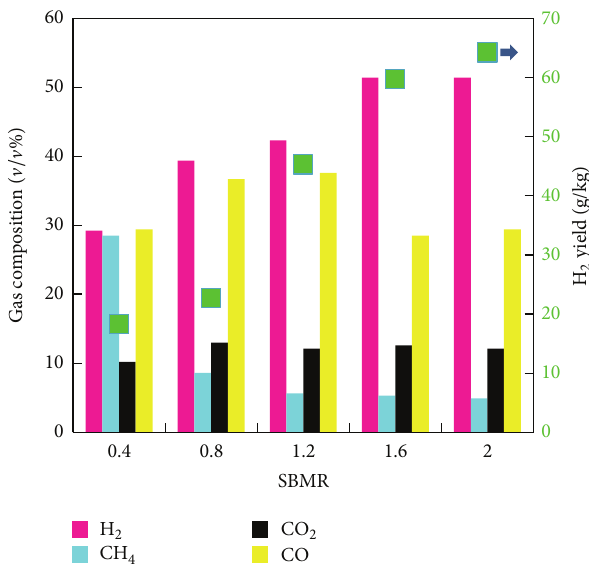
Figure 4: Influence of BCMR on H 2 -rich gas